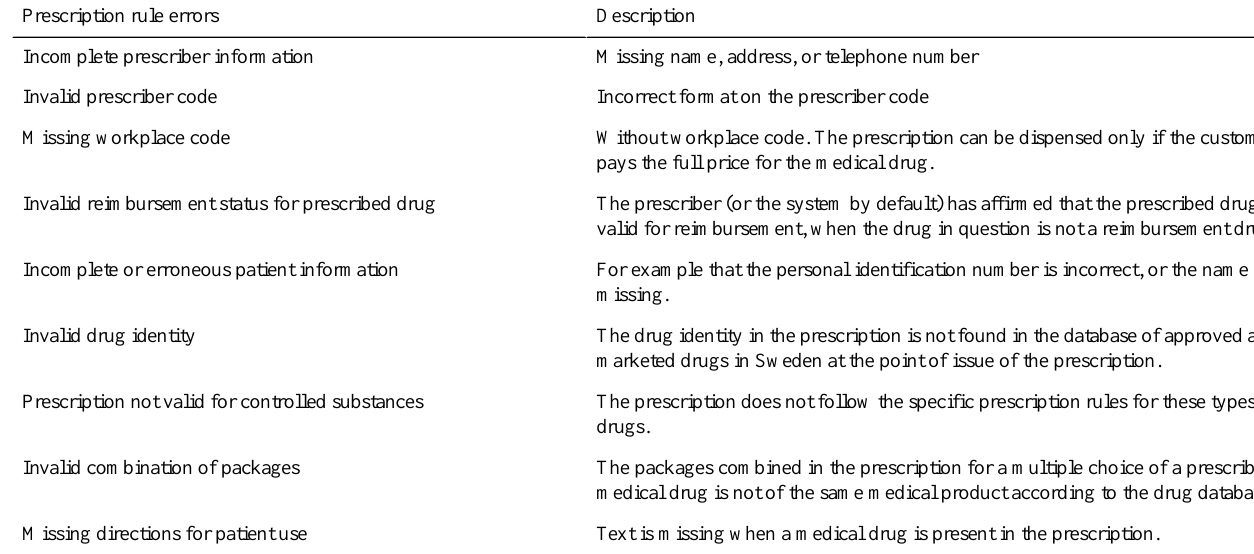
Table 4. Summary of prescription rule errors captured in